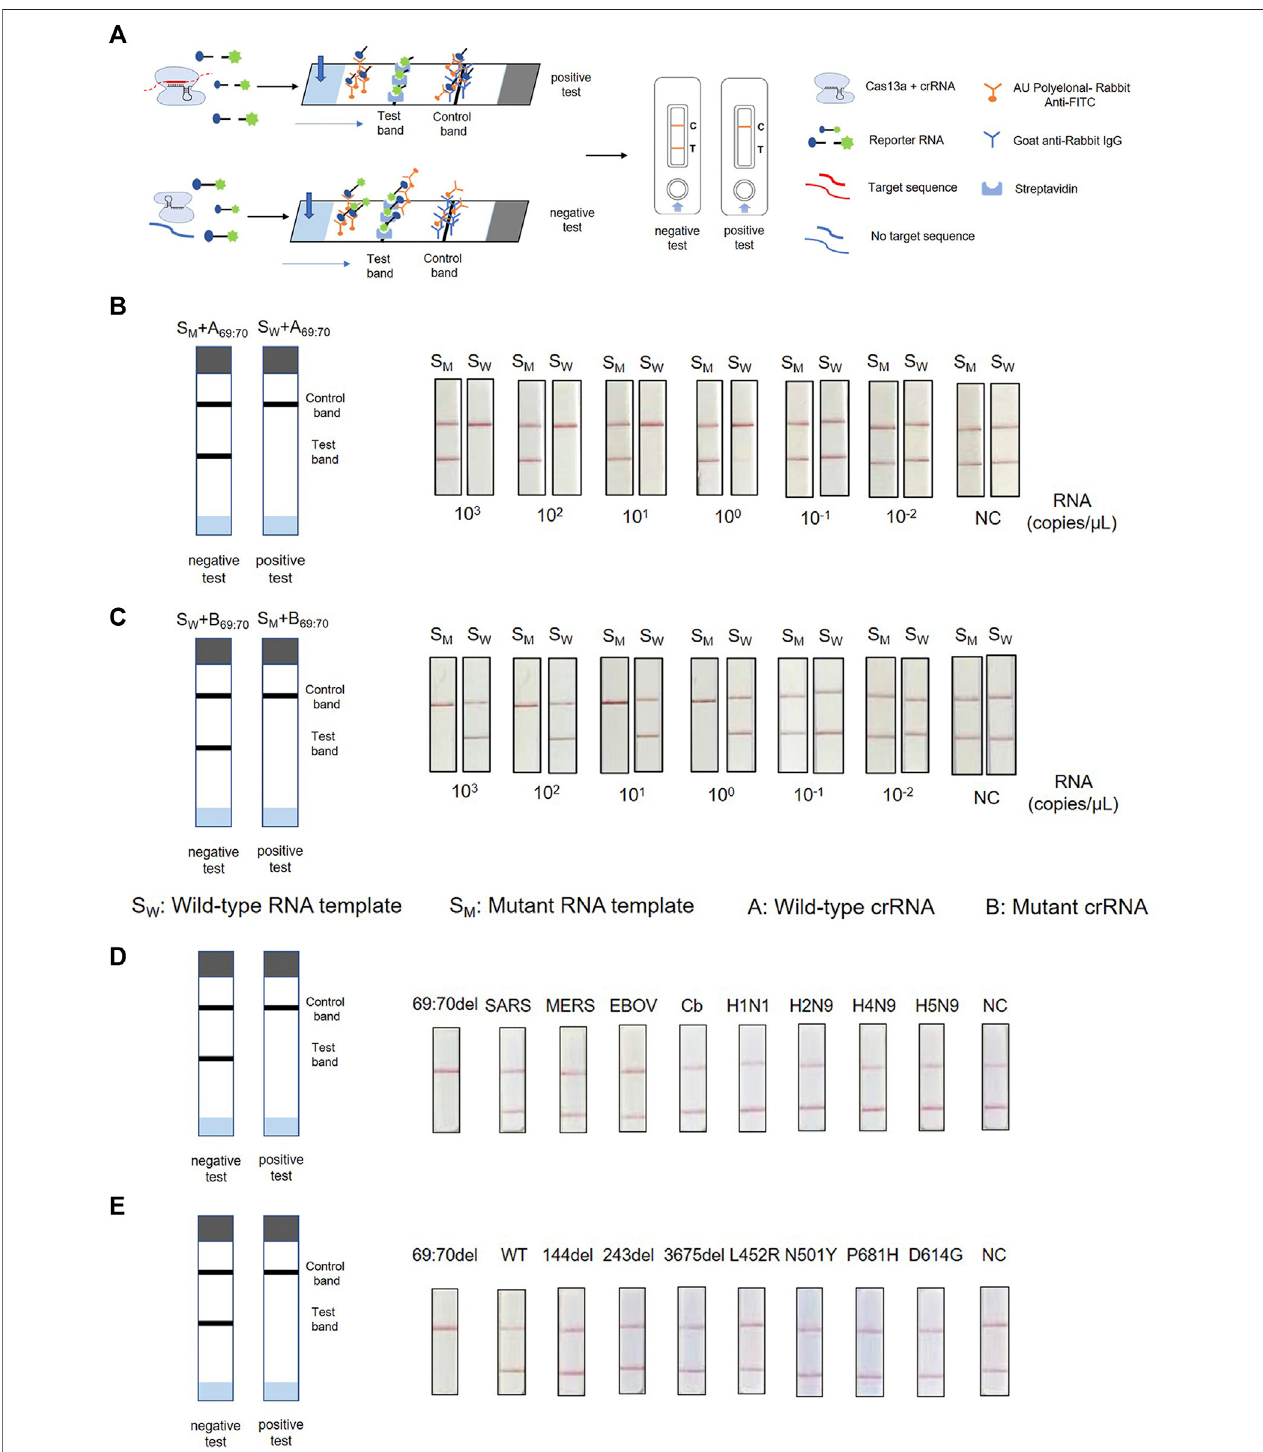
FIGURE4| CombinationofPCR-CRISPRdetectionwithERASEstripforlateral fl owreadout. (A) SchematicofPCR-CRISPRdetectionwithlateral fl owstrip. (B,C) Sensitivity of PCR-CRISPR detection with lateral fl ow strip. (B) Detection of wild-type target RNA by PCR-CRISPR and wild-type crRNA followed by application to the lateral fl owstrip. (C) DetectionofmutanttargetRNAbyPCR-CRISPRandmutantcrRNAfollowedbyapplicationtothelateral fl owstrip. (D,E) Speci fi cityofPCR-CRISPR detectionwiththelateral fl owstrip. (D) PCR-CRISPRwithlateral fl owstripcandiscriminateotherviralRNA. (E) PCR-CRISPRwithlateral fl owstripachievesspeci fi c detection of other viral mutant or deletion sites.